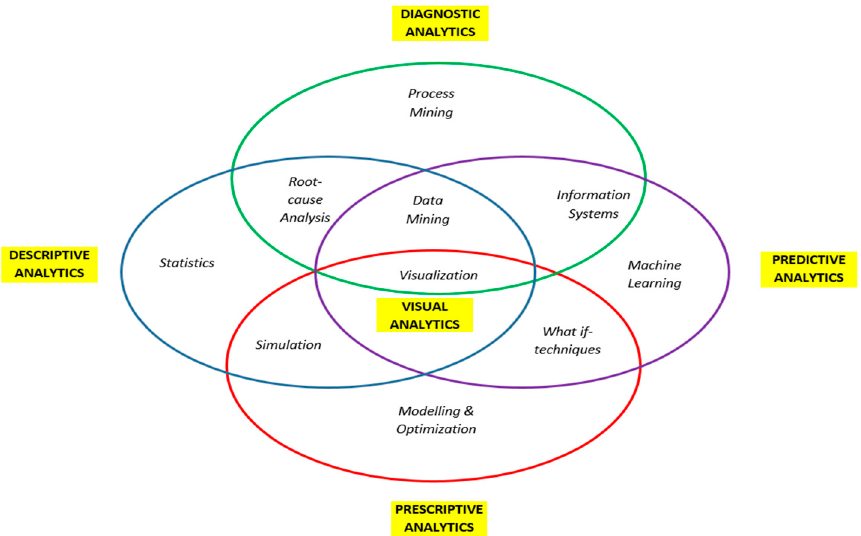
Figure 3. The confluence and radial layout of Visual Analytics in the context of BA and MA’s tasks and techniques (adapted after Nielsen 2018).